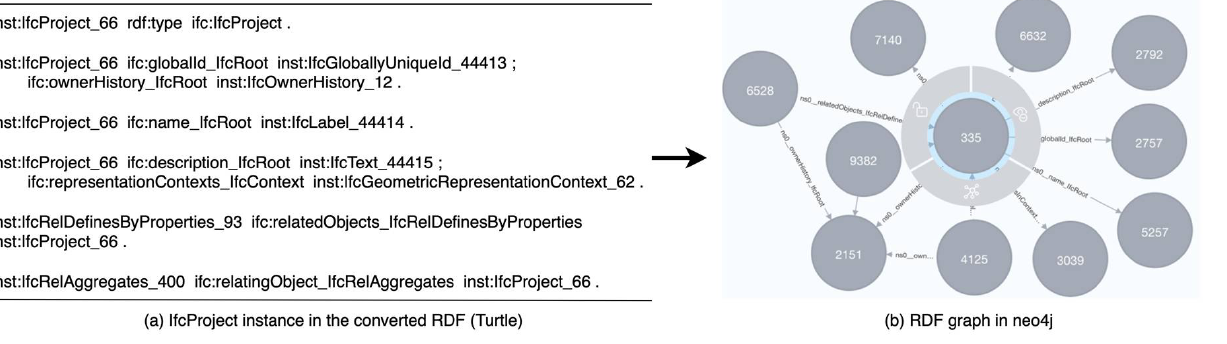
Figure 14. RDF data in ( a ) Turtle and ( b ) LPG representation.